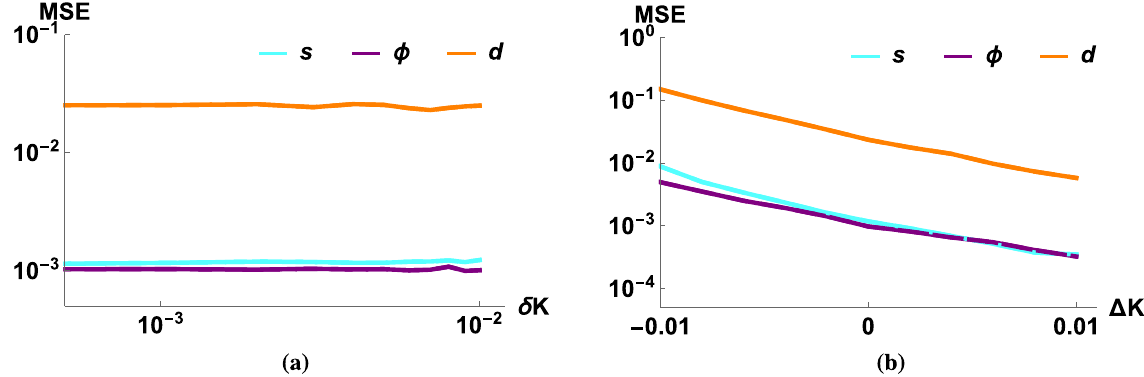
Figure 5. The MSE of the estimators of the Gaussian process as a function of ( a ) the variance of the transfer coefficient ( δ K ), ( b ) the bias of the transfer coefficient ( (cid:31) K ). The purple (dark) lines correspond to the phase shift, the orange (medium) lines correspond to the magnitude of the displacement and the cyan (light) lines 10 5 , r 10 2 , K 0.03 , T 0.99 , correspond to the magnitude of the squeezing. The parameters are N = = = = 3 0.03 , d 0.05 , β 1.02 , α 0.6 , V 10 , V th i : (cid:31) K i =0, 1 10 0.4 , s V GP 10 4 , ( a ) η , (cid:31) − = = = = − = ∀ − = = = = δ K